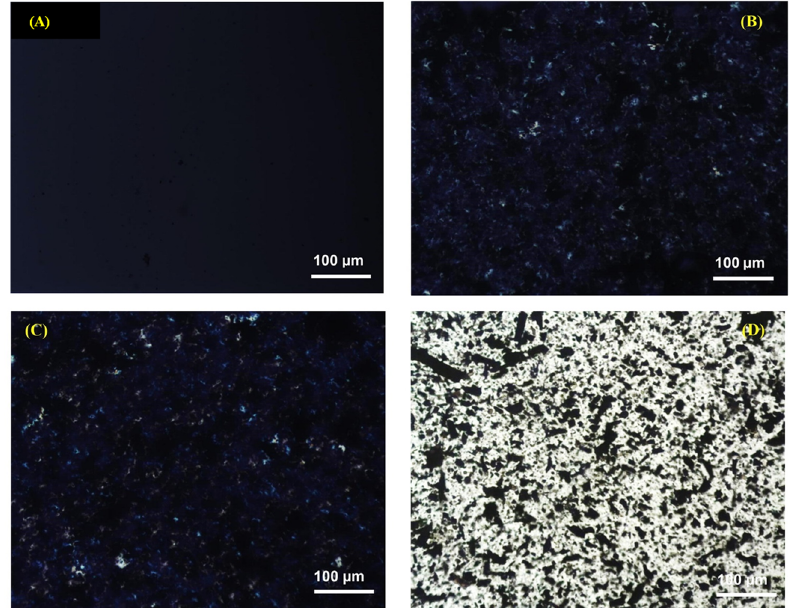
Figure 3. POM images of PP-based composite containing 15 wt.% of BC obtained at 500 °C; images taken at: ( A ) 0 min; ( B ) 2 min, ( C ) 5 min; and ( D ) 5 min without cross polarizer [57]. Reprinted under CC BY 4.0 license.